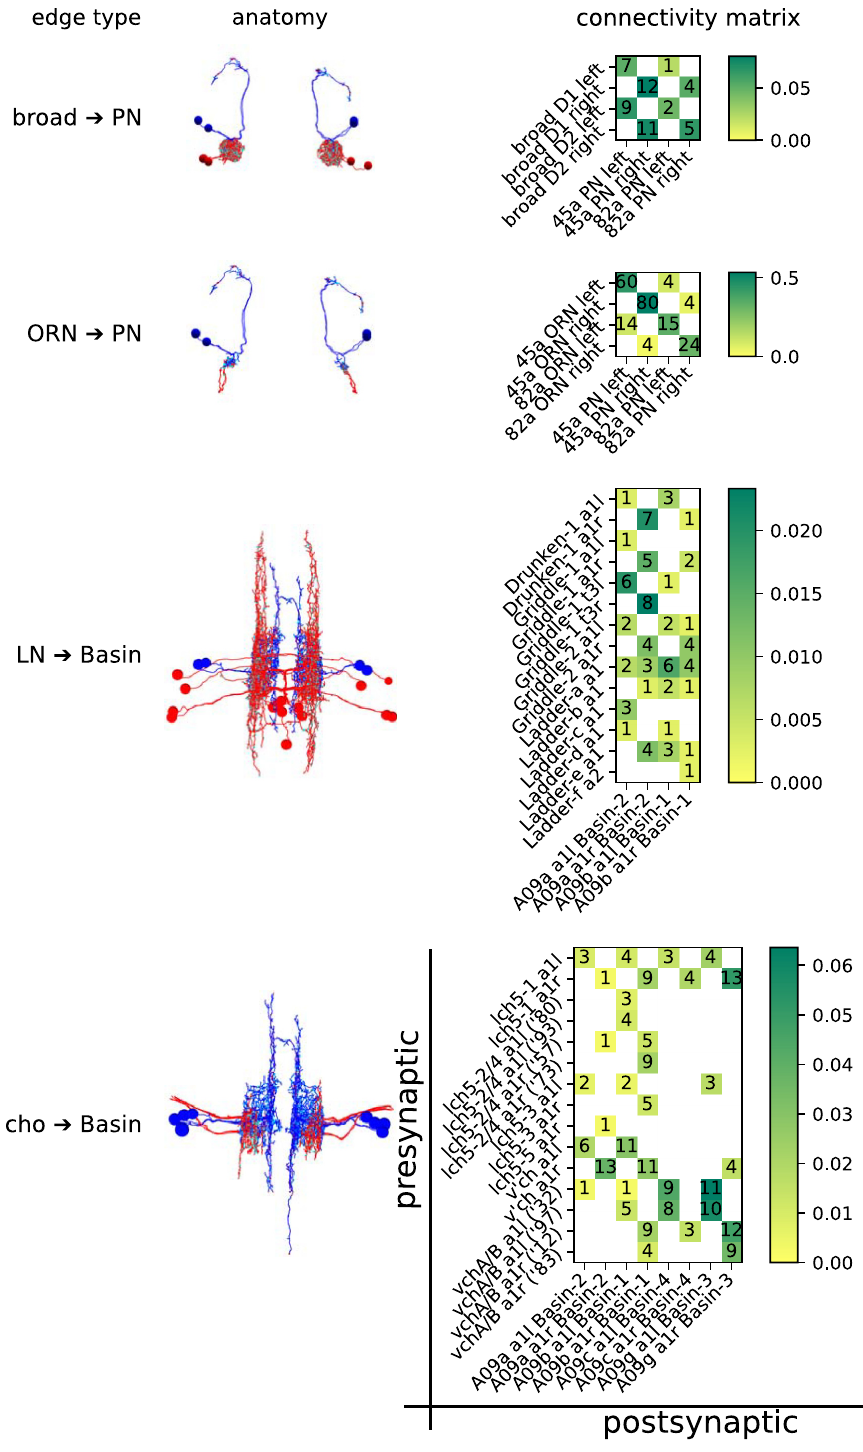
Fig 1. The anatomy and connectivity of the 4 circuits of interest. Presynaptic partners are shown in red, and postsynaptic in blue: synaptic sites are shown in cyan. PN-containing circuits are anterior XY projections. Basin- containing circuits are dorsal XZ projections. The connectivity matrices are have presynaptic partners on the Y axis, and postsynaptic partners on the X axis. Ambiguous pairs of neurons (lch5–2/4 and vchA/B, which are indistinguishable as their cell bodies lie outside the VNC) are distinguished by a truncated reconstruction ID. Squares in the connectivity matrix are coloured by what fraction of the target’s dendritic input, by contact number, is